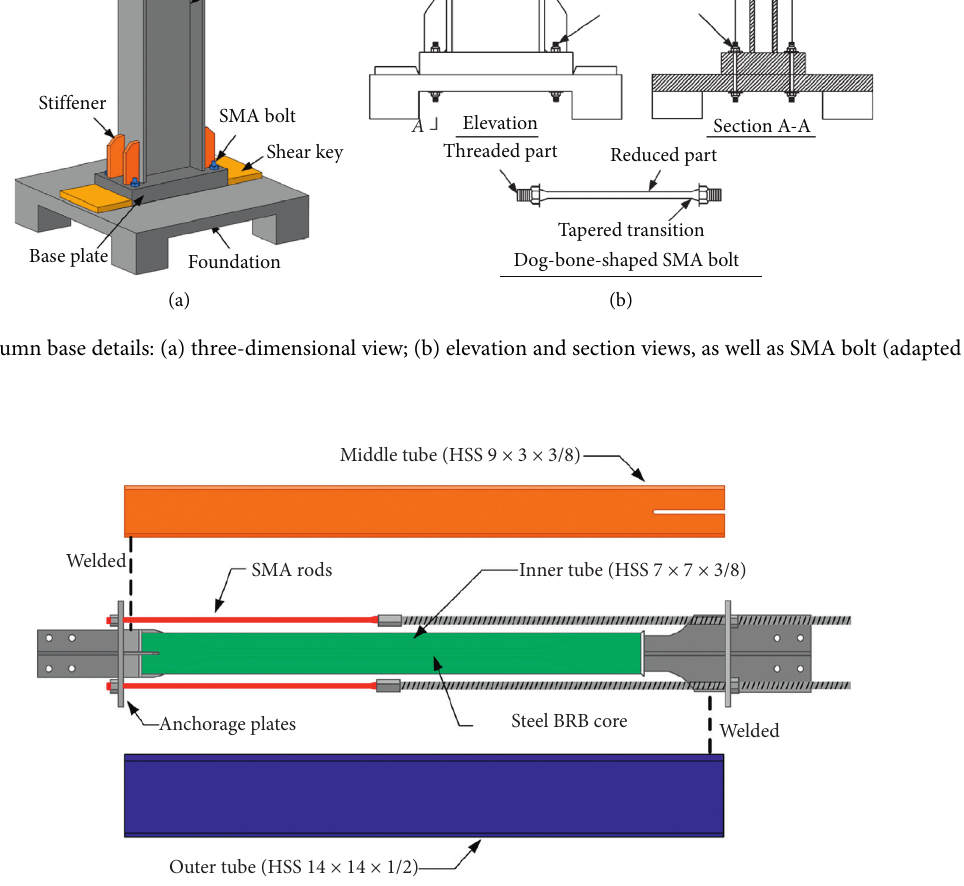
Figure 14: SC-BRB components (adapted from [57]).